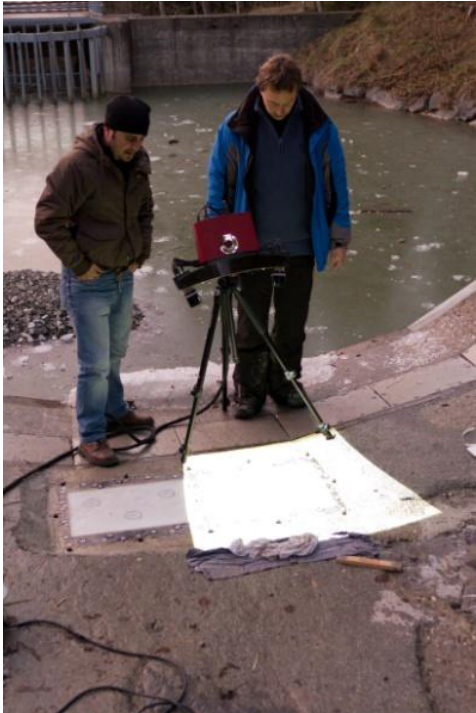
Figure 6. Structured light scanning at the Erlenbach site.